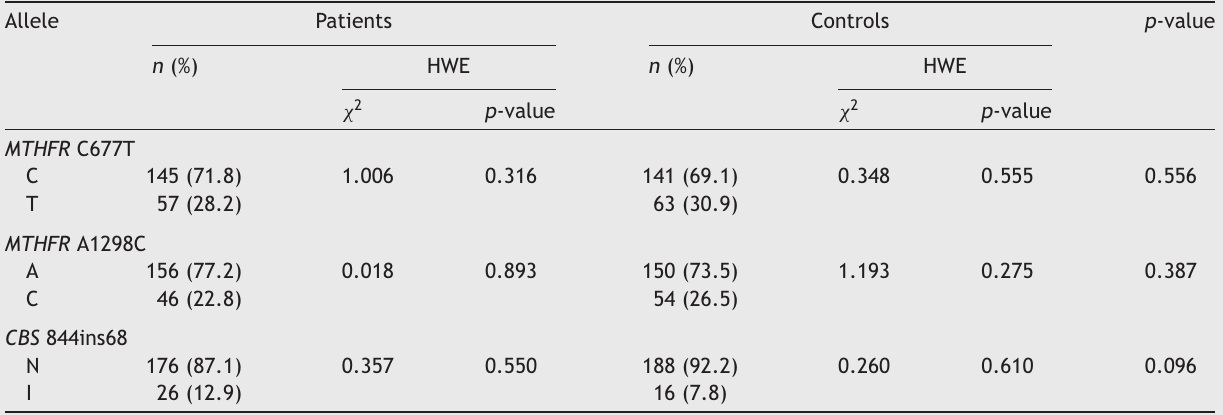
Distribution of MTHFR and CBS alleles among the oral cancer patients and control groups. Allele